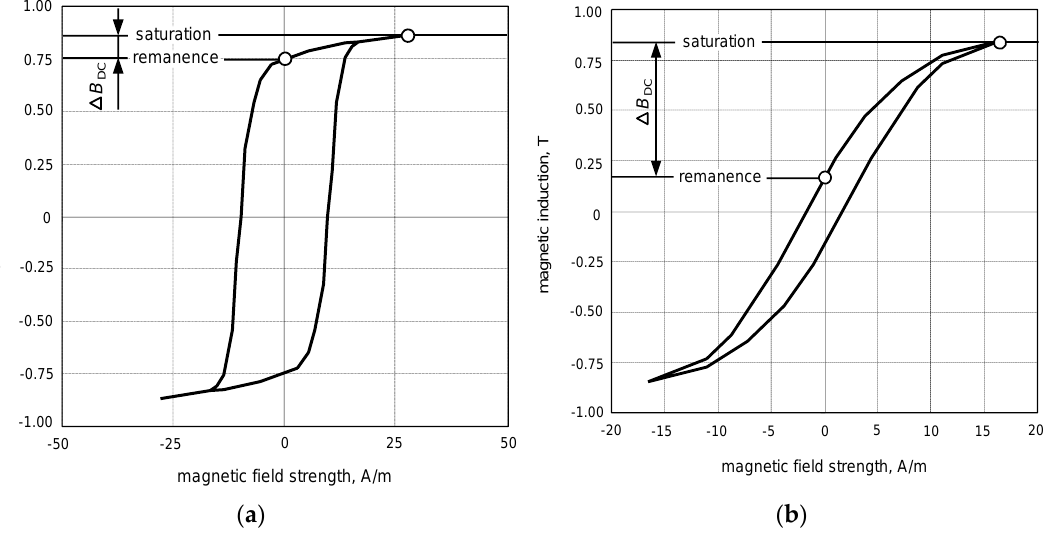
Figure 15. Magnetization characteristics (measured, for 50 Hz) of current transformer cores from RCDs: ( a ) AC-type (here called round hysteresis loop); ( b ) A-type (here called flat hysteresis loop). ∆ B DC — variation of the induction between the remanence point and the saturation point.